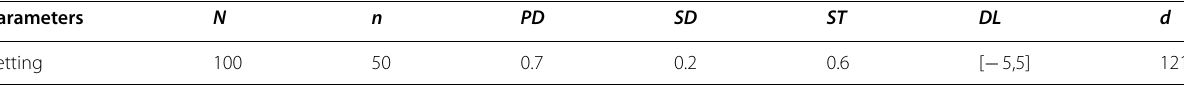
Table 6 The super parameters that can be adjusted in the SSA algorithm Parameters